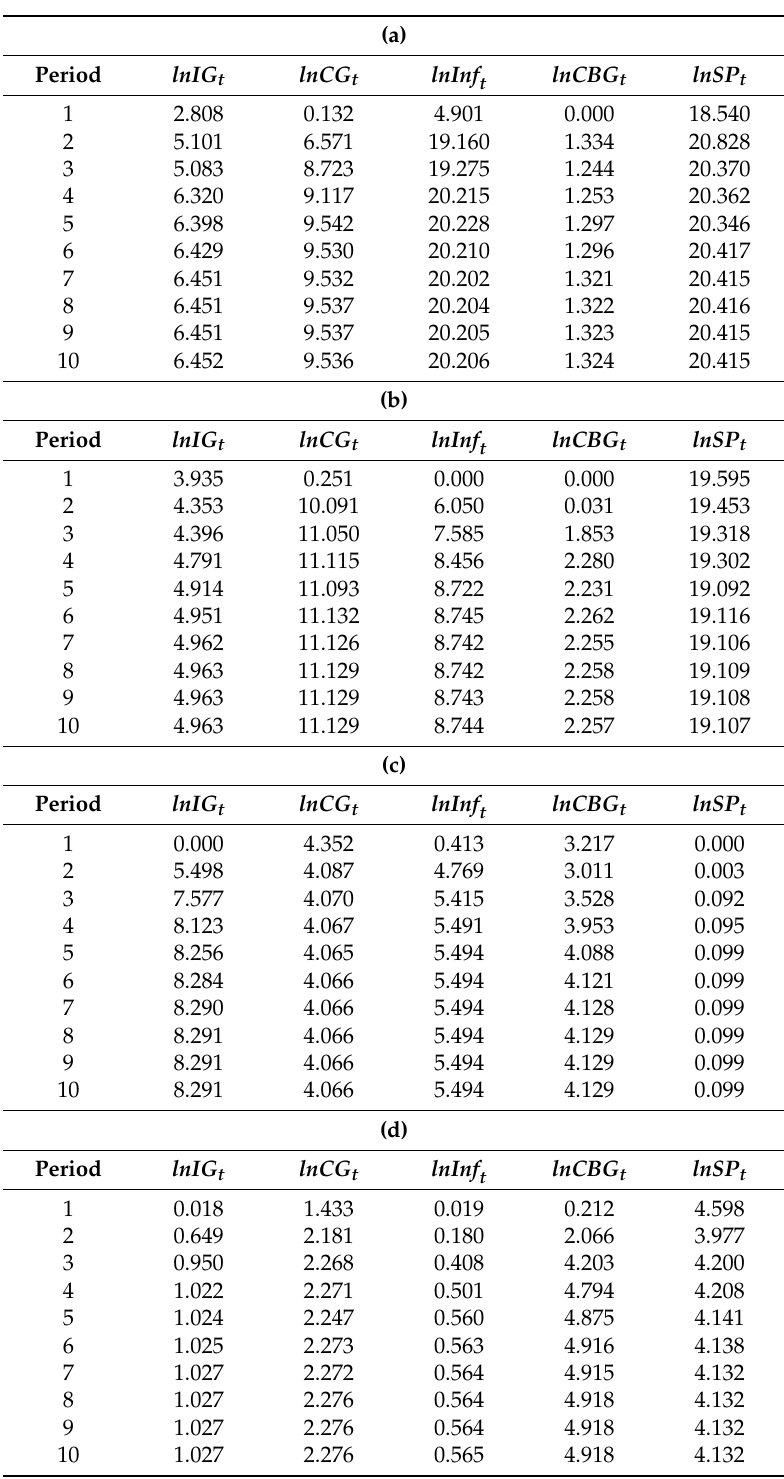
Table 4. Russia. ( a ) Variance Decomposition of Domestic EPU. ( b ) Variance Decomposition of USA EPU. ( c ) Variance Decomposition of UK EPU. ( d ) Variance Decomposition of Europe